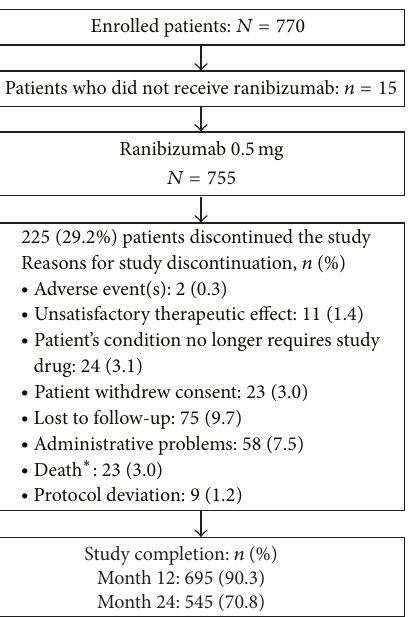
Figure 1: Patient disposition (all enrolled patients). ∗ Except for one, none of the deaths were suspected to be related to the study